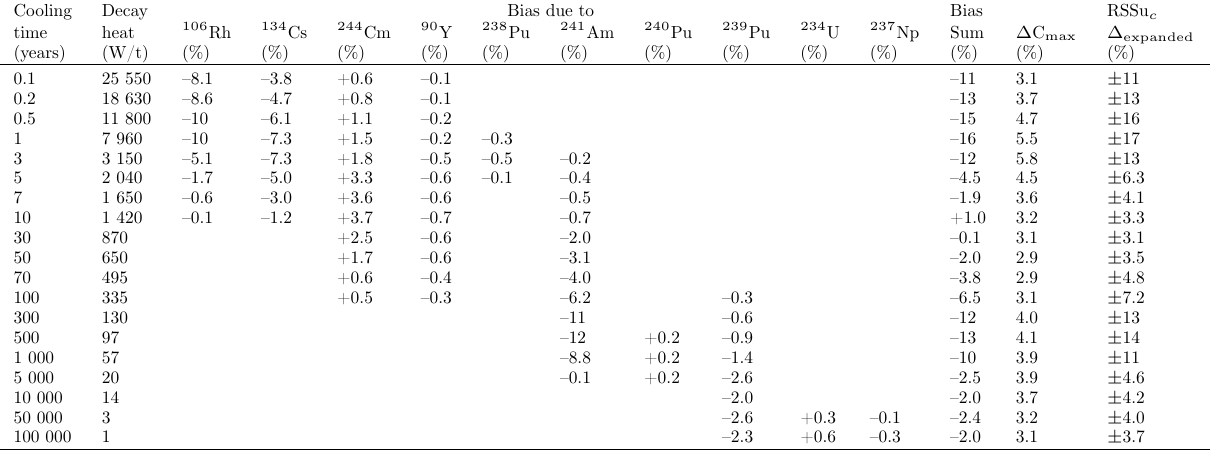
Table A.5. Expanded estimated uncertainties ∆ expanded for the decay heat from the ENRESA-1 sample, taking into account the main calculation biases for isotopic concentrations from Table A.3 and calculated uncertainties from Table A.4. ∆ C max come from the nuclear data library leading to the highest nuclear data uncertainty